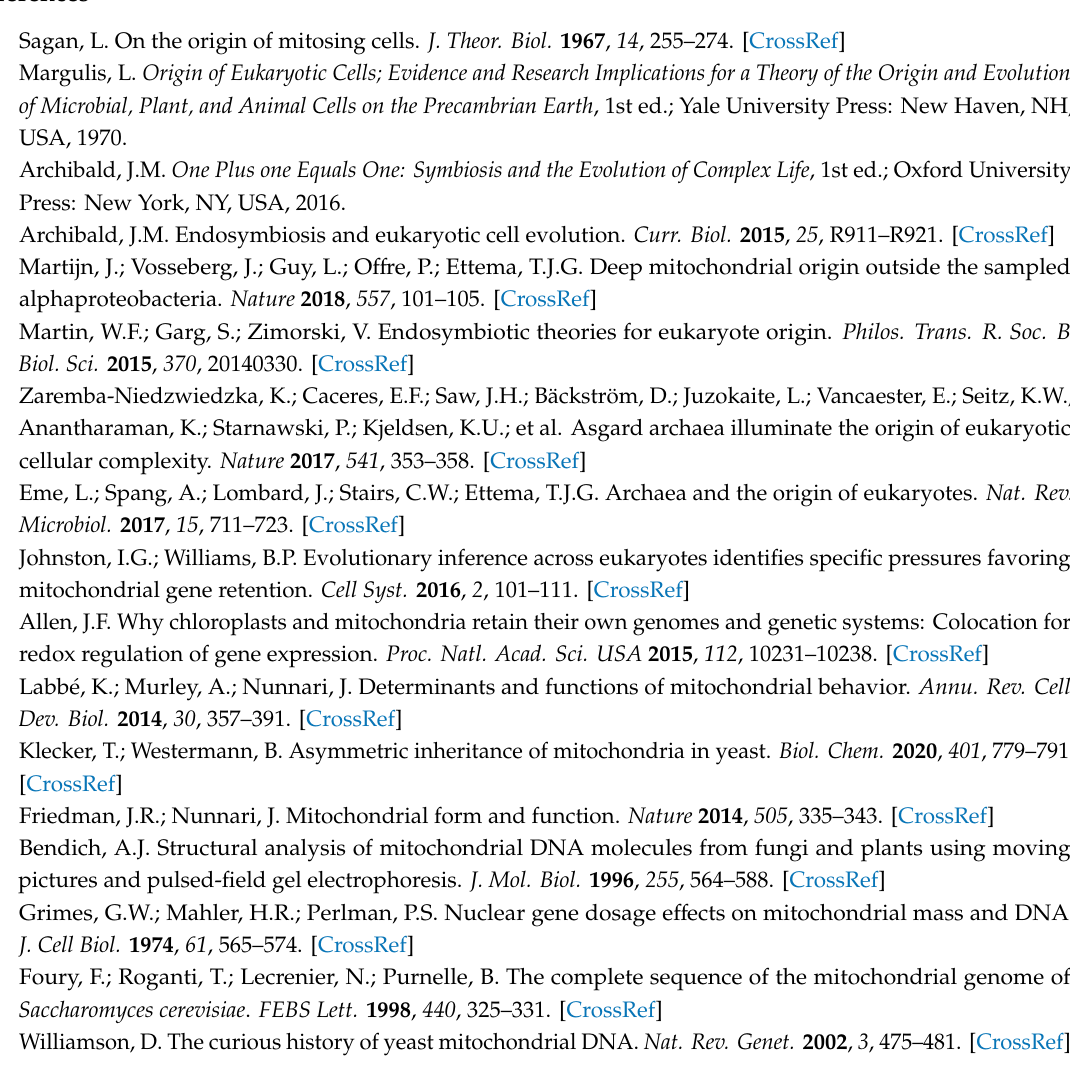
s1. Table S1: Examples of diseases correlating with changes in TFAM levels and / or functions; Figure S1: Amino-acid sequence alignment of HMG-box domains 1 and 2 from yeast (Abf2, Gcf1, Mhb1) and human (TFAM) mtHMG